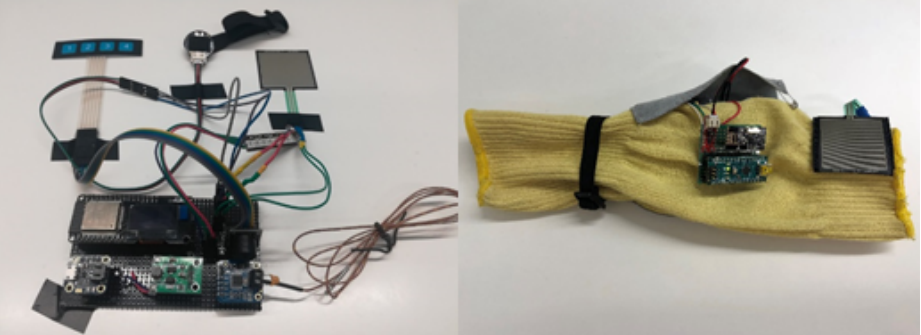
Figure 4. Bracelet with electronic components and their deployment on the fabric.